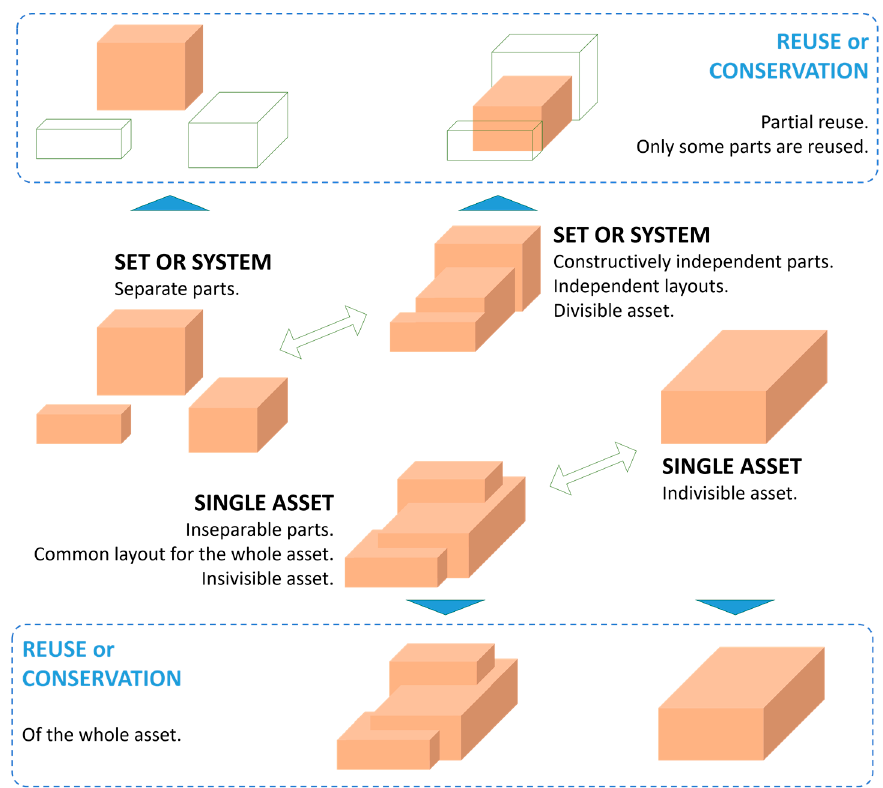
Figure 5. Graphical guidelines for the classification as a single asset or as a set of assets.